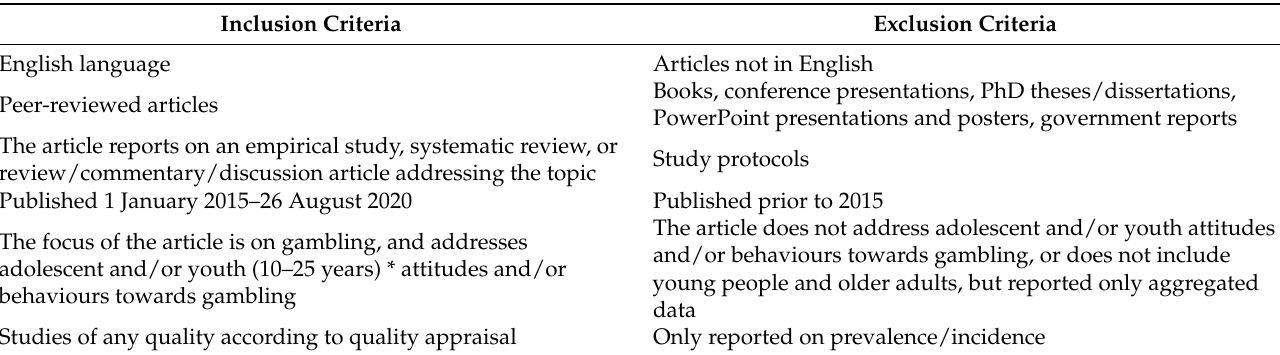
Table 1. Inclusion and exclusion